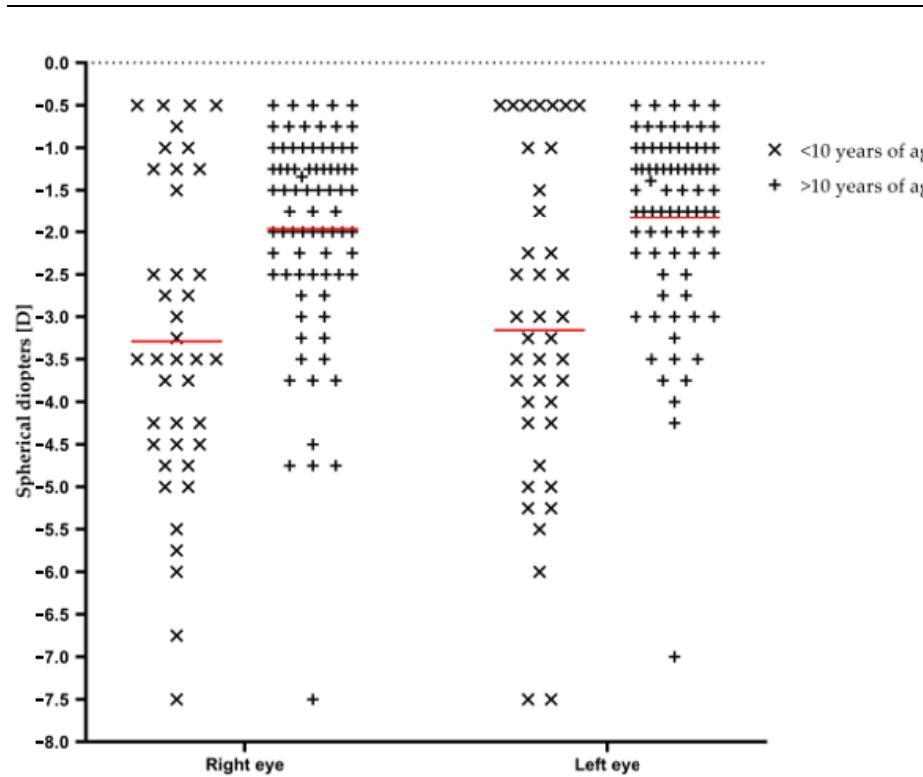
Figure 2. Refraction error in participants grouped by the age of diagnosis ( a ) Right eye and ( b ) Left